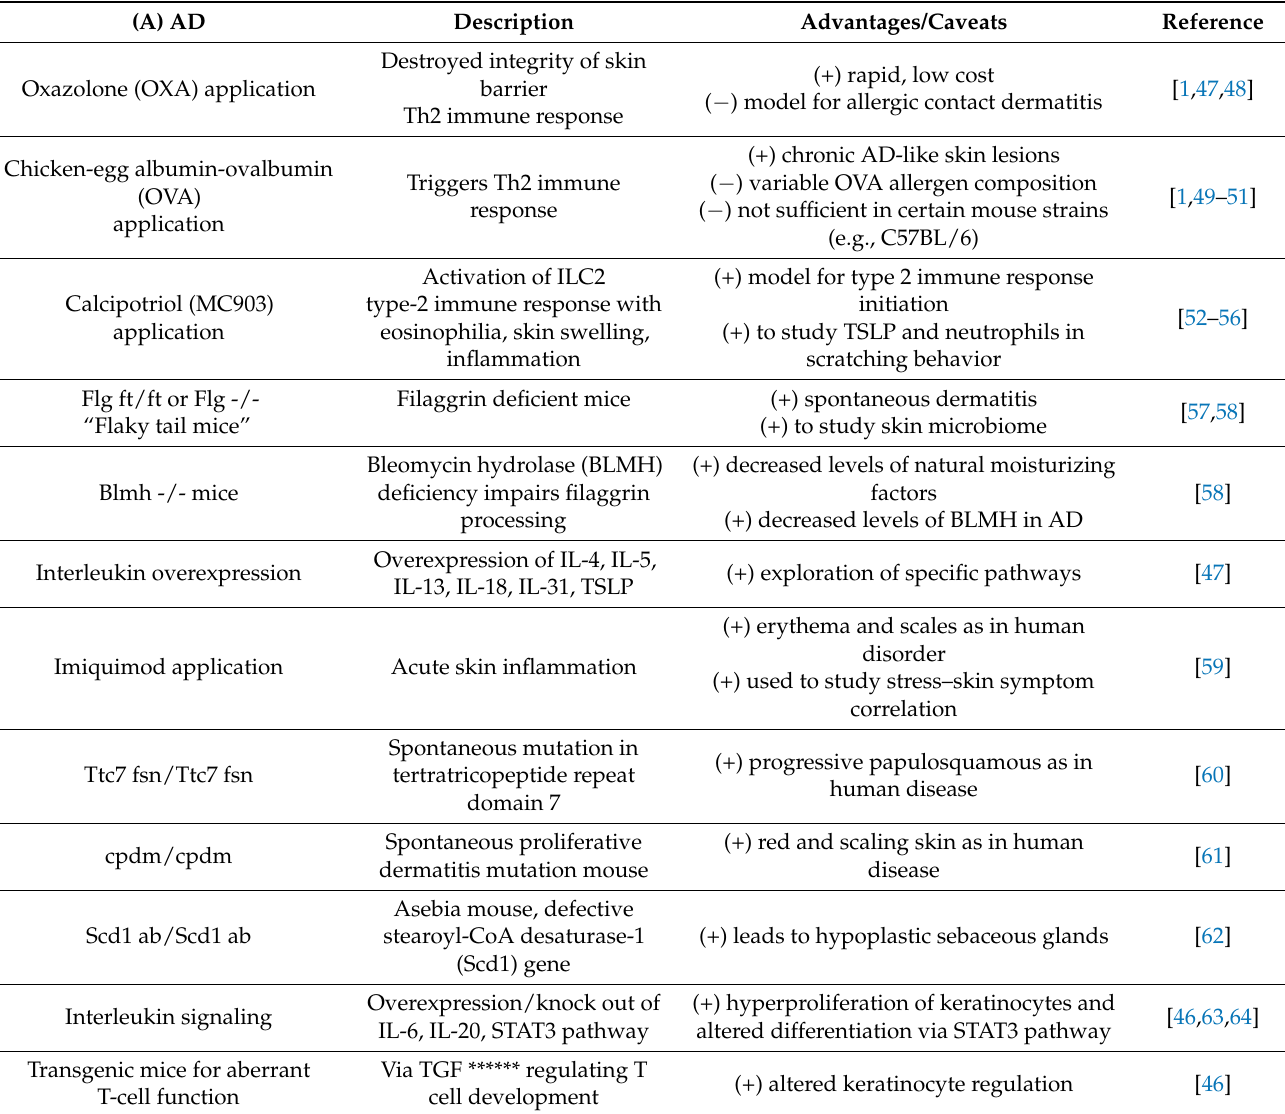
Table 2. Mouse models to probe the skin–brain axis. Mouse models for atopic dermatitis (AD) and